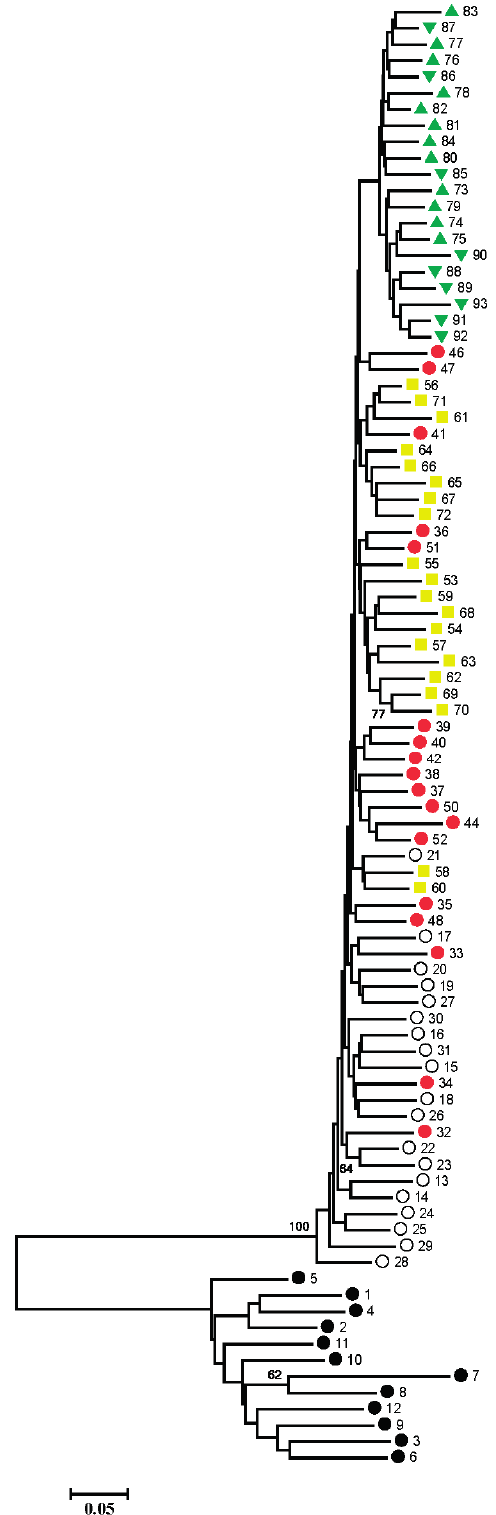
Figure 3. NJ tree of all individuals based on the genetic distance (Black circles, 1–12: Coilia mystus ; White circles, 13–32: Zhenjiang; Red circles, 33–52: Nantong; Yellow squares, 53–72: Dongying; Regular triangles, 73–84: Kashima; Inverted triangles, 85–93: